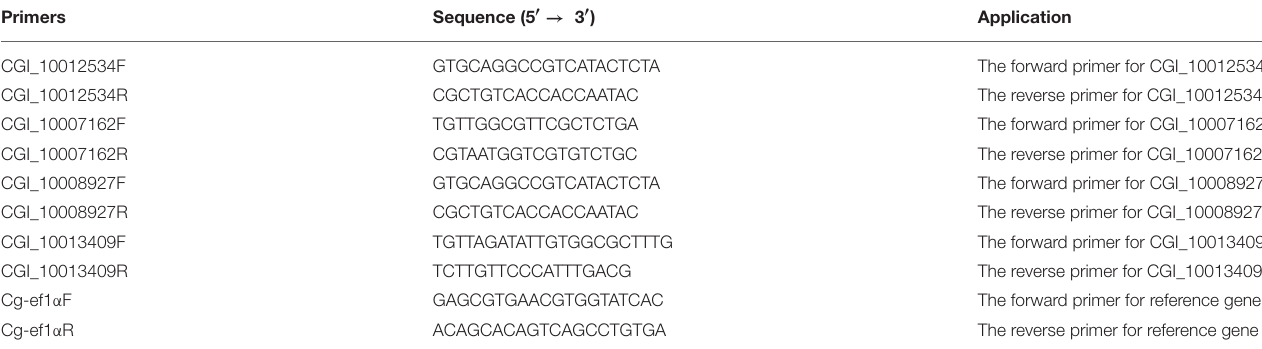
TABLE 2 | The primers used in qPCR experiment.